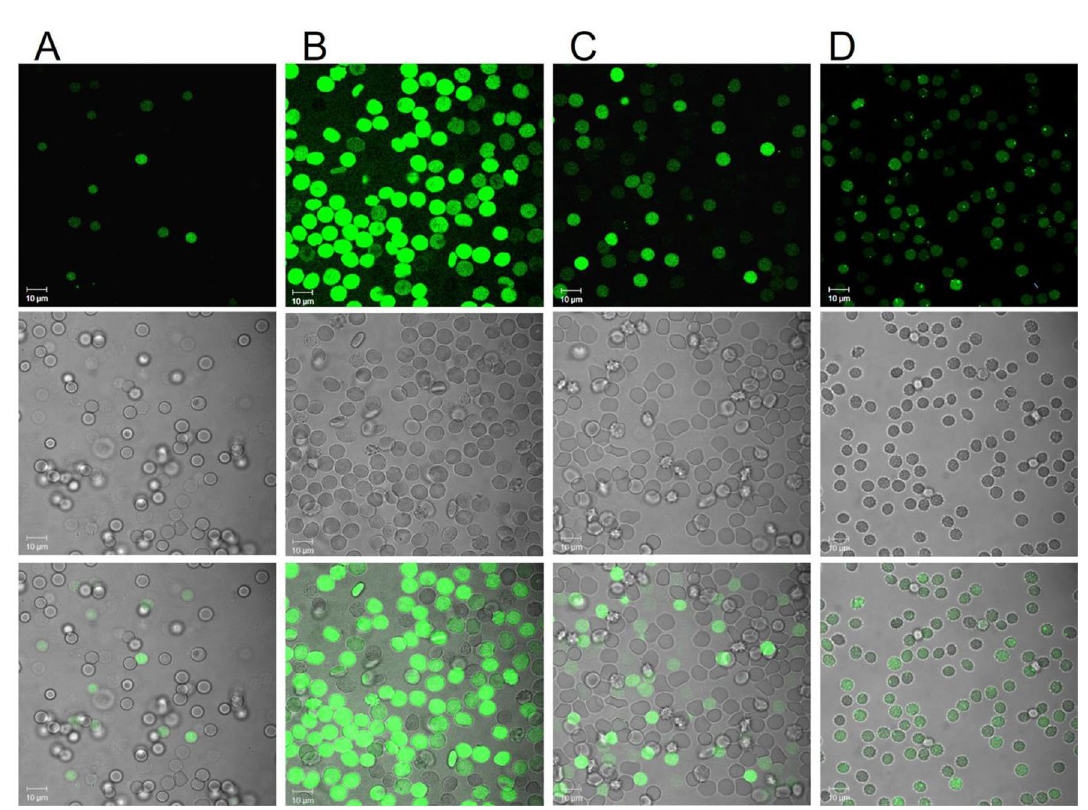
Figure 4. Supravital visualization of ROS level by fluorescent redox probe DCF-DA (10 µM, 30 min, 37 °C) in confocal microscopy: ( A ) control RBC (PBS), ( B ) 60 mM AAPH (2 h), ( C ) derivative 18 (0.1 mg/mL, 20 min preincubation) + 60 mM AAPH (1.5 h), ( D ) Trolox (0.1 mg/mL, 20 min preincubation) + 60 mM AAPH (1.5 h). The upper panel—fluorescence images, the middle panel—transmitted light images, the bottom panel—merge fluorescence and transmitted light images. The representative images of a series of experiments are presented. Scale bar = 10